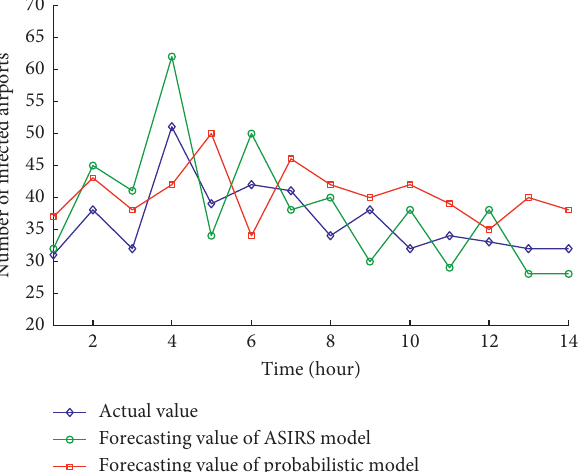
Figure 13: Comparison of actual and forecasting